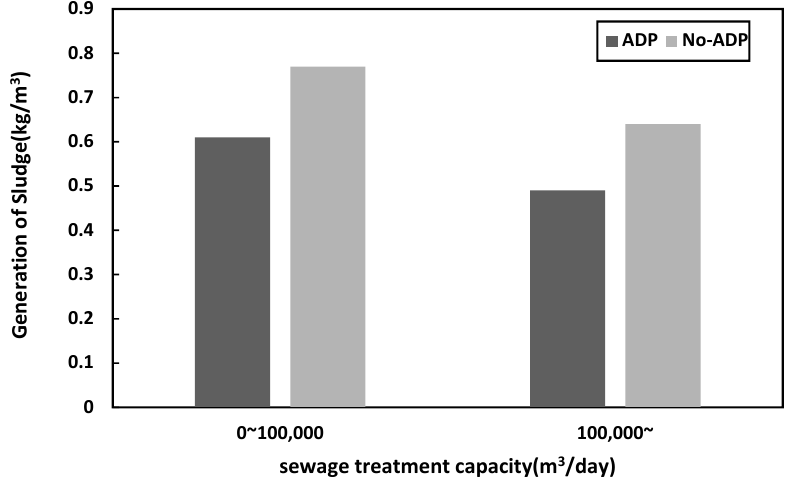
Figure 5. The amount of SS generated compared to the unit throughput capacity according to whether or not an ADP is installed. The dark bar indicates the basic unit of SS generation of STP that performs only SS-ADP, and the light bar indicates the basic unit of SS generation in STP that does not have an ADP.